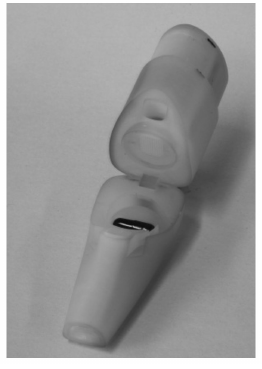
Figure 1. Unihaler.